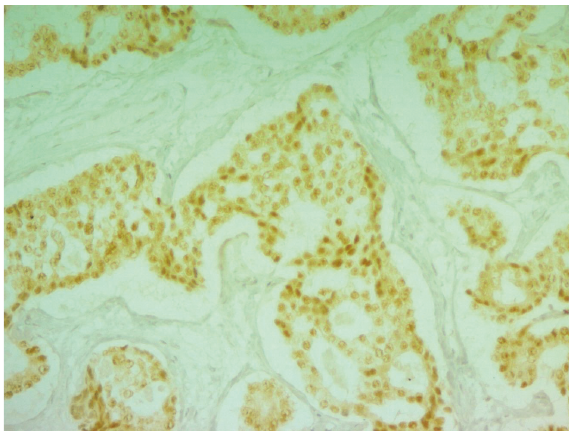
Figure 5: CDX2 immunohistochemical stain (nuclear staining)